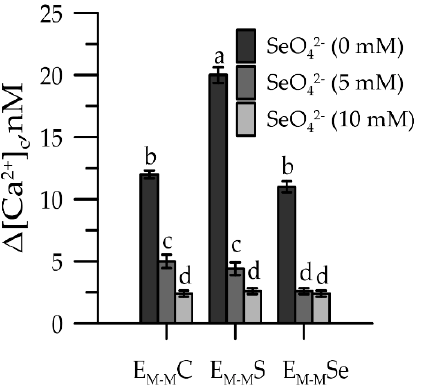
Figure 5. Effects of emmer wheatgrass extracts (50 μ g) extracted in methanol and resuspended in methanol (E M-M ) on the cytosolic Ca 2+ of maize pollen in the absence or in the presence of 5 and 10 μ M Na-selenate (SeO 42 − ). Wheatgrass extracts were obtained from grains sprouted with distilled water as a control (E M-M C) or in the presence of salinity (NaCl 50 mM) (E M-M S) or selenium (Na 2 SeO 3 45 mg L − 1 ) (E M-M Se). Data are expressed as means ± SEM from five independent tests. Different letters above bars indicate significant differences at p ≤ 0.05, whereas same letters indicate non-significant differences.